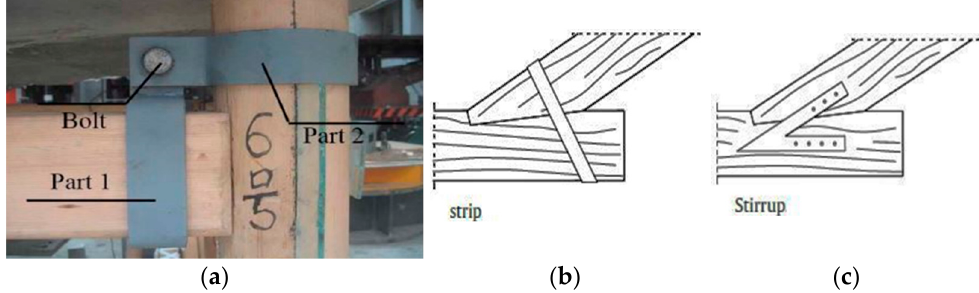
Figure 15. Strengthening timber connections using ( a ) steel plates [109], ( b ) strip, and ( c ) stirrup [110].